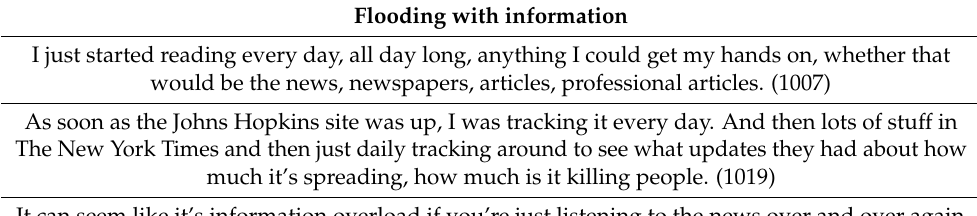
Table 4. Themes and quotes related to the regulation of information flow. Flooding with